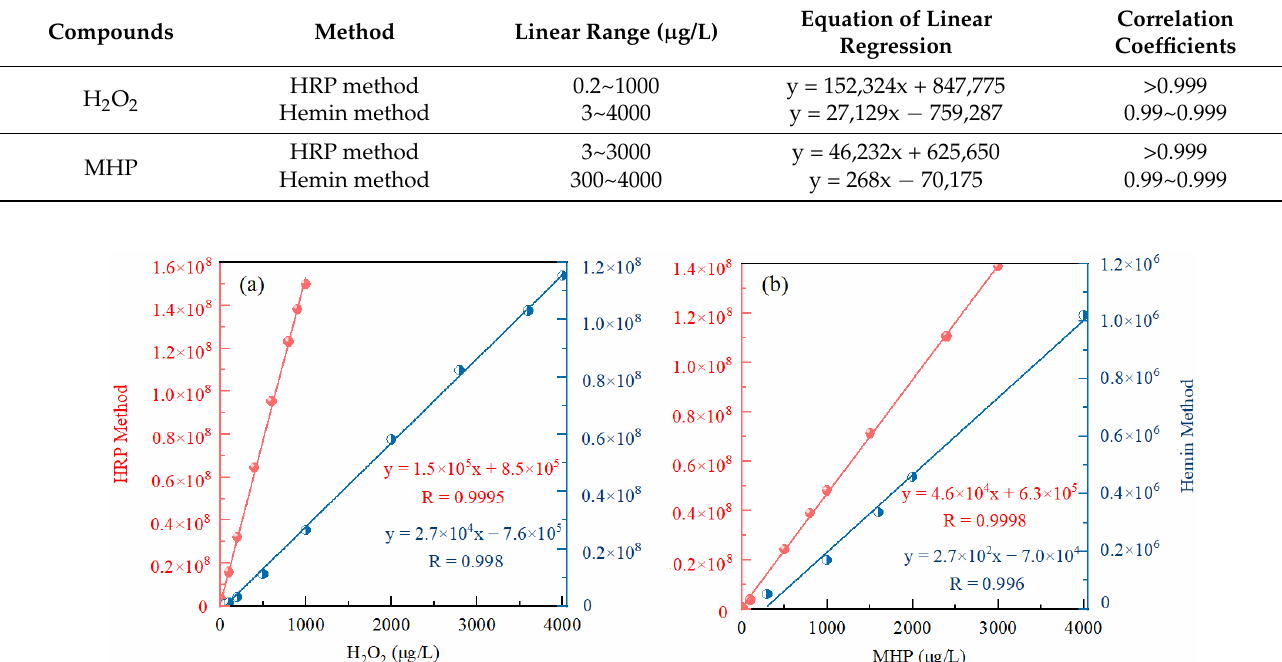
Figure 7. The calibration curves of ( a ) H 2 O 2 and ( b ) MHP by two methods.